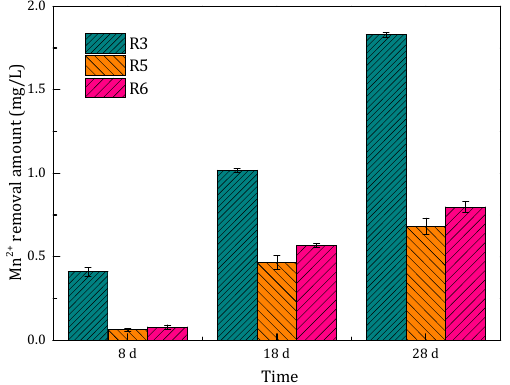
Figure 7. Comparison of the Mn 2+ removal amount of the filters (R3, R5 and R6) at different running times.